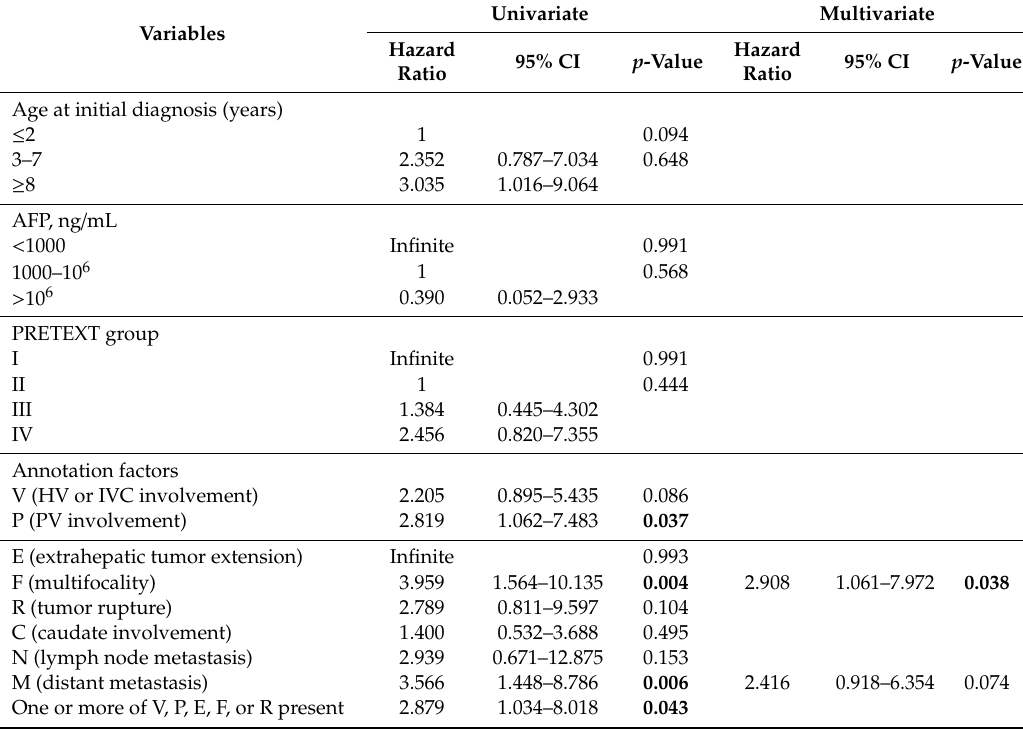
Table 3. Cox proportional hazards model with variables used in the 2017 PRETEXT and CHIC-HS